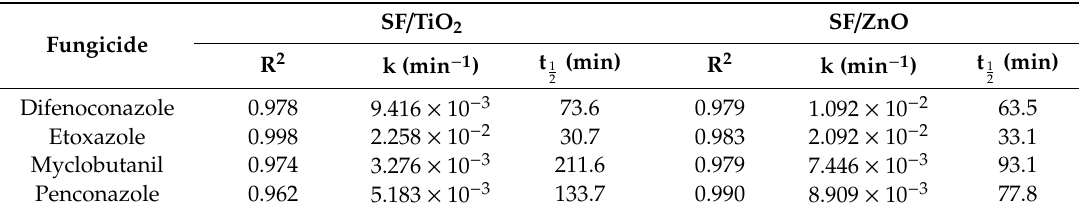
Table 2. Kinetic parameters for photocatalytic treatments (SF / TiO 2 and SF / ZnO) of pesticides in water under natural